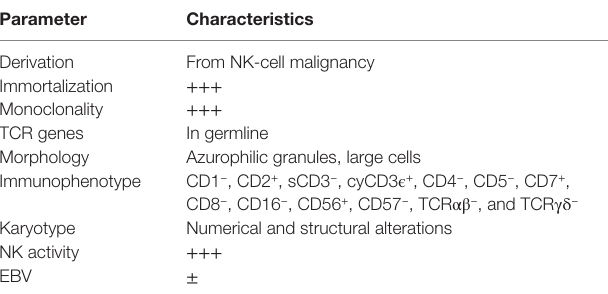
TABLe 2 | Operational definition of NK-cell lines.